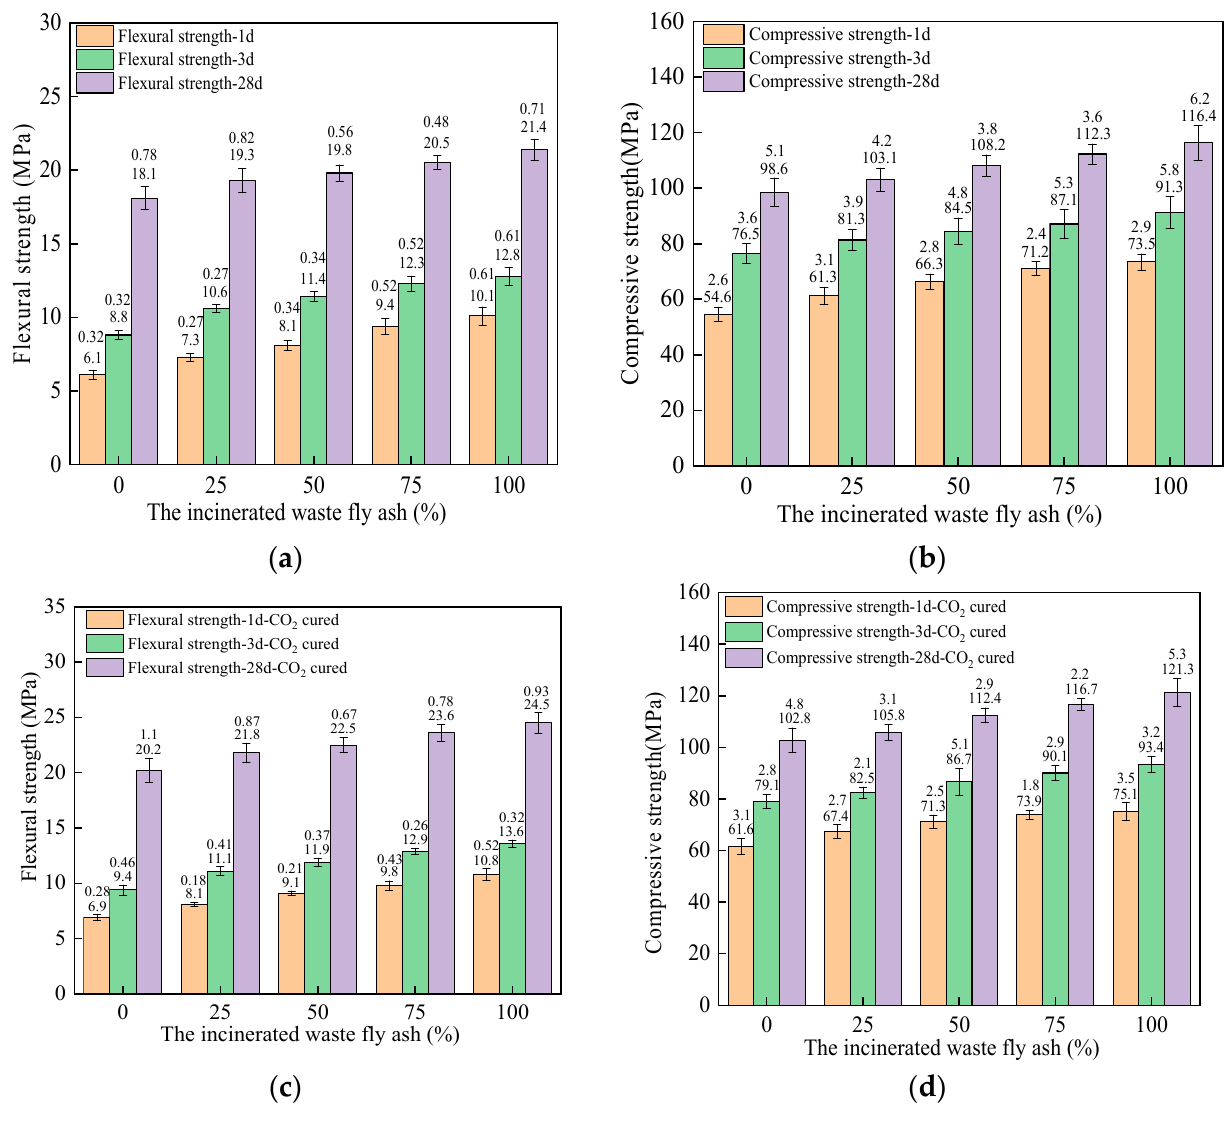
Figure 6. The mechanical strengths of RPC with conventionally treated incinerated waste fly ash. ( a ) Flexural strength. ( b ) Compressive strength. ( c ) Flexural strength. ( d ) Compressive strength. The increasing rates of mechanical strengths are shown in Figures 7 and 8. As observed in Figures 7 and 8, the increasing rates of mechanical strengths increase with the increasing dosages of WFA and decrease with increased curing age. This is because the WFA can improve the mechanical strengths of RPC. However, the WFA can increase the hydration degree of cement in RPC and the improvement in earlier curing age is higher than that in later curing age [43,44]. Additionally, the increasing rates of mechanical strengths of RPC with CO 2 -cured WFA are lower than those of RPC with conventionally WFA, due to the decreased activity of WFA by CO 2 curing [45]. The increasing rates of flexural and compressive strengths of RPC by WFA are 6.6%~65.6% and